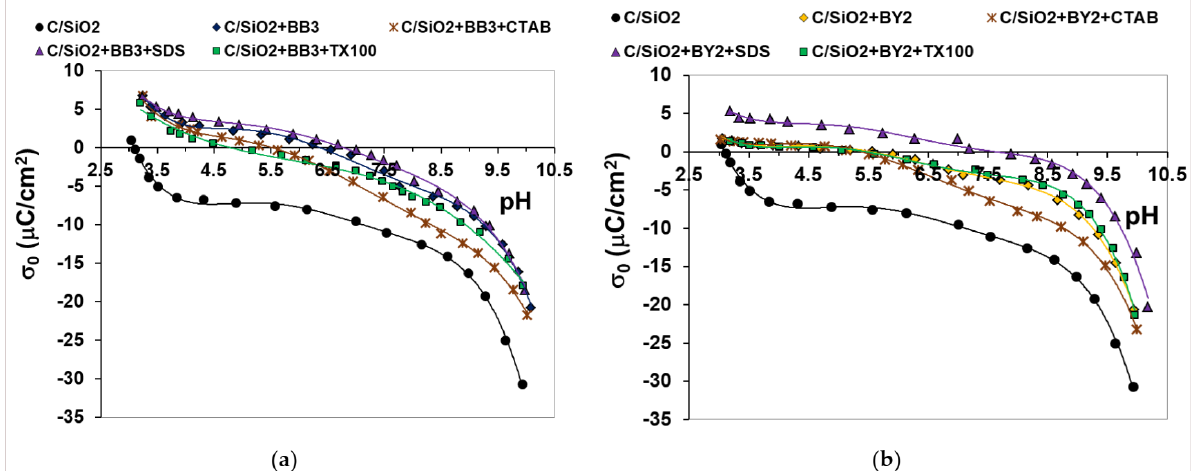
Figure 8. ( a ) Dependencies of the C/SiO 2 surface charge density vs. solution pH in the systems containing BB3 dye and surfactants with different ionic character; ( b ) Dependencies of the C/SiO 2 surface charge density vs. solution pH in the systems containing BY2 dye and surfactants with different ionic